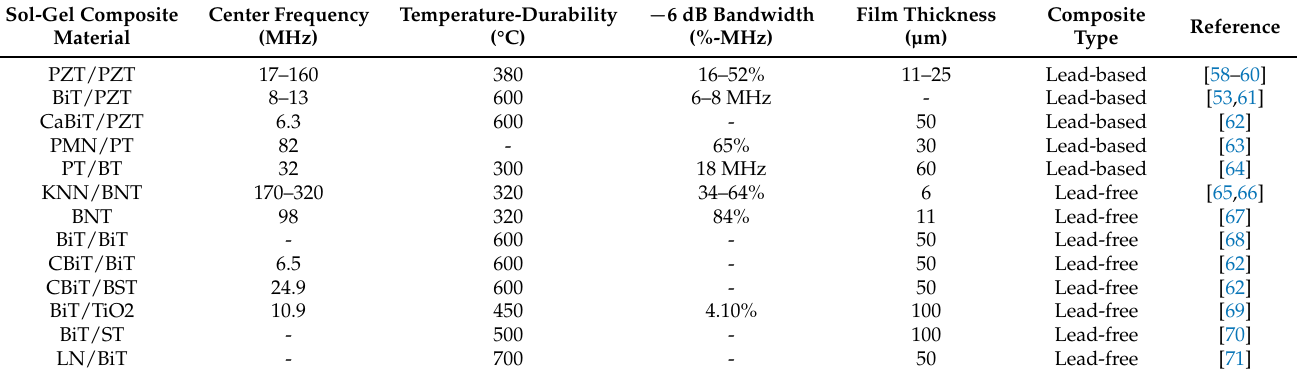
Table 3. Lead-free and lead-based sol-gel composites and the ultrasonic properties. Sol-Gel Composite Center Frequency Material